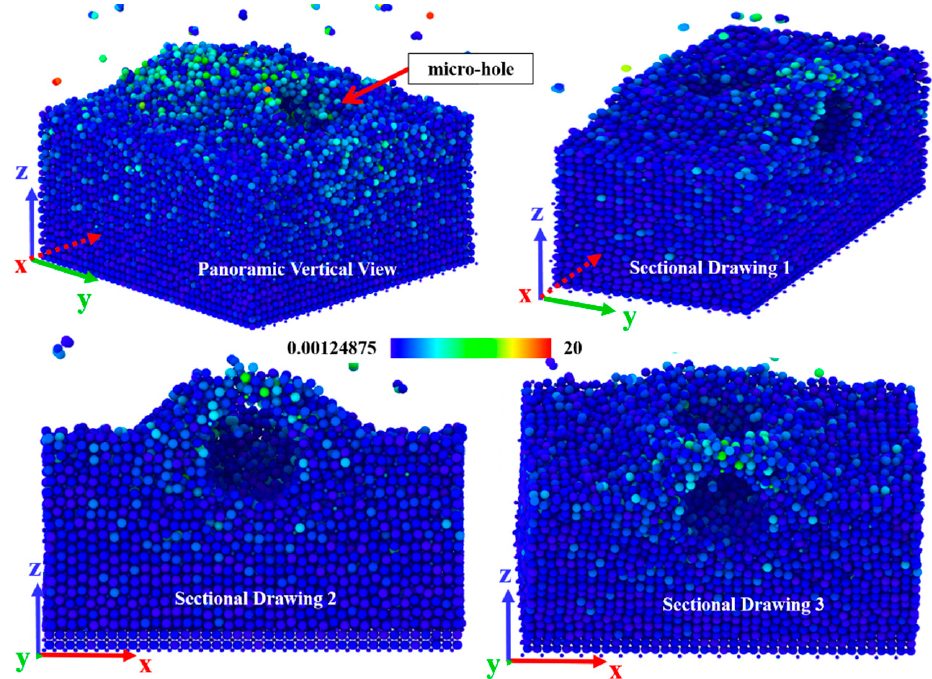
Figure 7. The panoramic vertical view and sectional drawings of structure changes when the abrasive particle have both normal pressure and tangential friction on the surface.